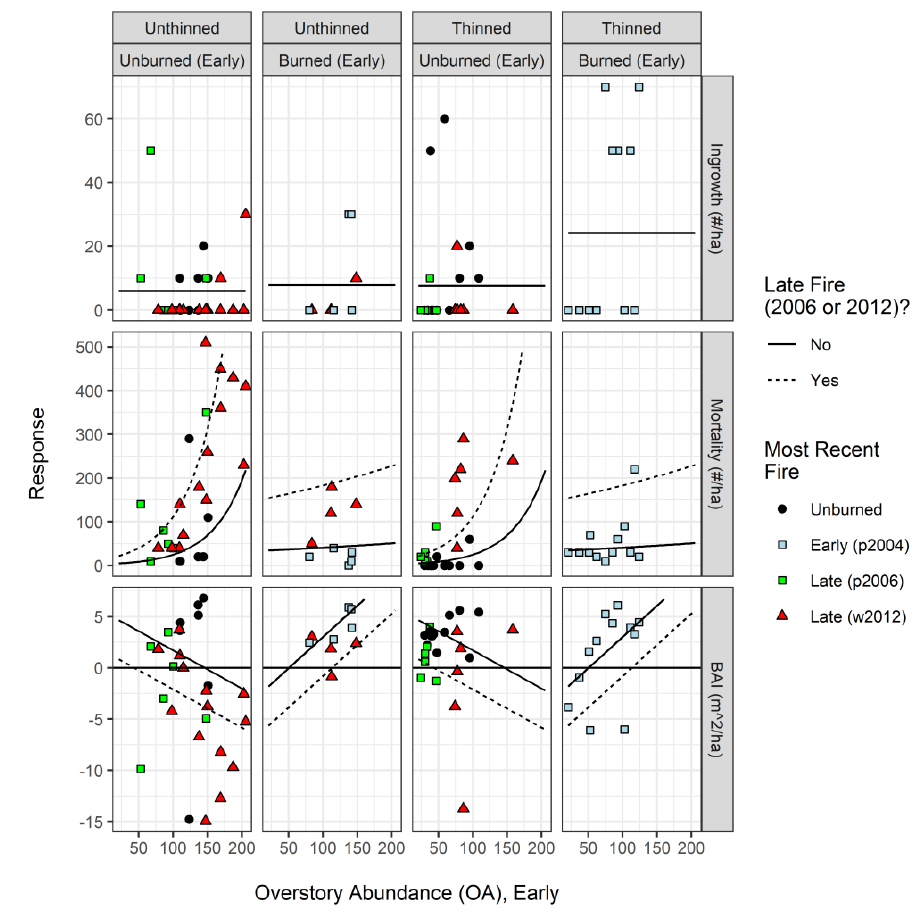
Figure 3. Measures of overstory dynamics after treatment (Early–Late interval, 2004–2015). Rows differentiate response variables (ingrowth, mortality, and basal area increment [BAI], as defined in Table 1). Points represent plots with different overstory abundance (OA) values in the Early sample and different histories of thinning and fire (columns and symbols). Columns distinguish thinning and Early (2004) prescribed-fire treatments. Symbols represent the most recent fire (′p′ for prescribed fire and ′w′ for wildfire). Dashed and solid lines are modeled relationships for the Late-fire treatment based on statistically significant terms (Table 2). For ingrowth, OA and the Late-fire treatment were not significant, thus single horizontal lines are shown.